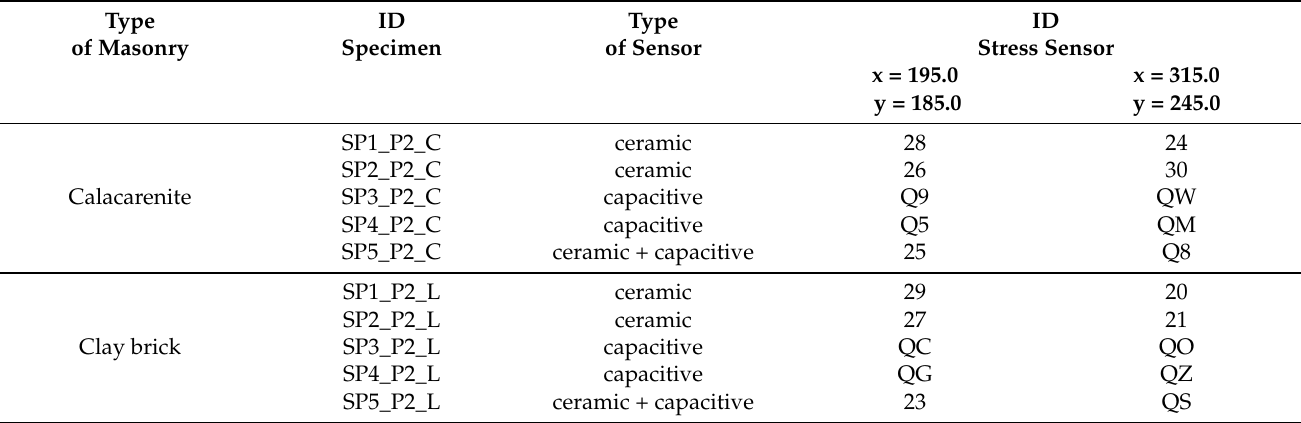
Table 2. Specimens and sensors post-installed with method P2 (dimensions in